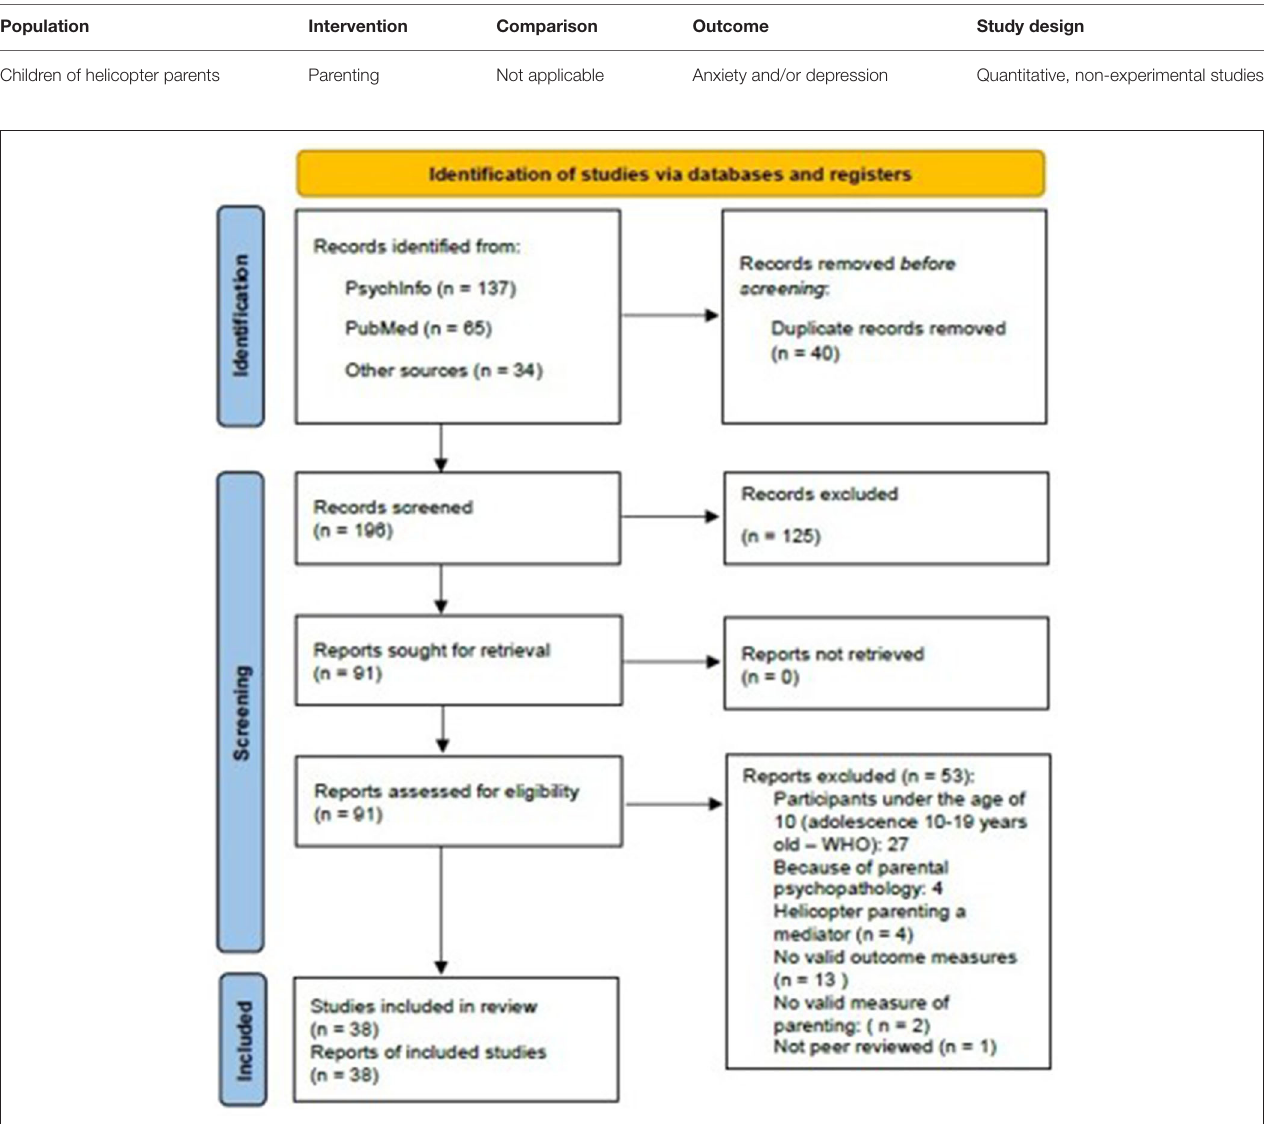
TABLE 1 | Eligibility criteria in accordance to PICO(S).